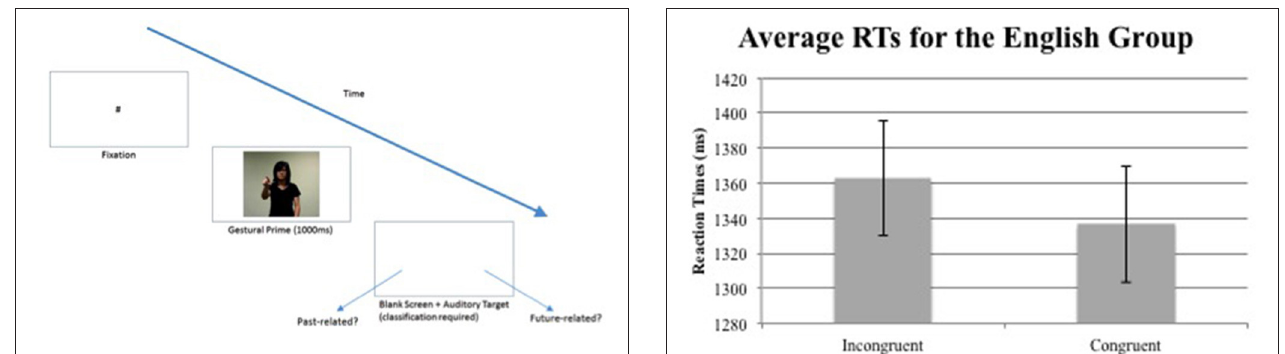
FIGURE 3 | Basic outline of each trial. The individual in the picture above is that of a research assistant employed by our lab and consent was obtained from this individual for the publication of the image.